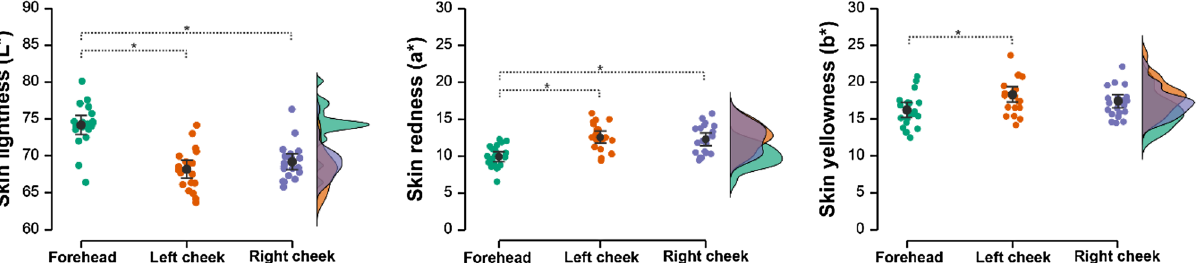
Figure 2. Differences in skin colour (CIE L*a*b*) measured from right and left cheek and the forehead. Black dots represent mean values, error bars show their 95% confidence intervals. Coloured points represent individual data points, while density plots show their distribution. Statistically significant differences are marked by Neither redness, yellowness, nor lightness of the forehead or left cheek predicted elevations in any of the specific antibodies (Anti-HAV: R 2 = 0.447, R 2 adj = − 0.210; Anti-Mnk: R 2 = 0.350, R 2 adj = 0.071). For detailed results, see Table 3. Running a linear mixed-effects model, we found that neither the levels of cortisol or testosterone, nor the percentage of adipose tissue predicted perceived facial attractiveness (R 2 C = 0.534, R 2 M = 0.099). For details, see Table 4. In a GLM analysis, neither the levels of testosterone or cortisol, nor the percentage of adipose tissue predicted elevations in any of the specific antibodies Anti-HAV (R 2 = 0.084, R 2 adj = − 0.078) and Anti-Mnk (R 2 = 0.186, R 2 adj = 0.042). For detailed results, see Table 5. In a linear mixed-effects model testing the influence of skin colour on perceived facial attractiveness (R 2 C = 0.540, R 2 M = 0.190), forehead redness was the only statistically significant predictor with a negative slope (β = − 0.490 [− 0.780, − 0.201]); see Table 6.